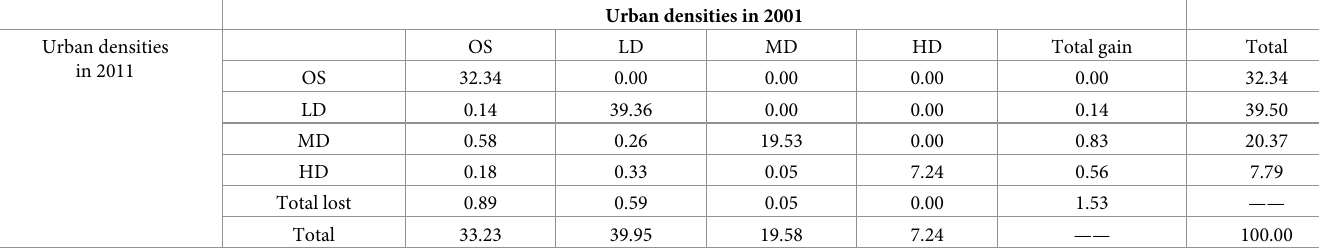
Table 4. Urban density transition matrix in SEWI (2001–2011 by percent transitioned).